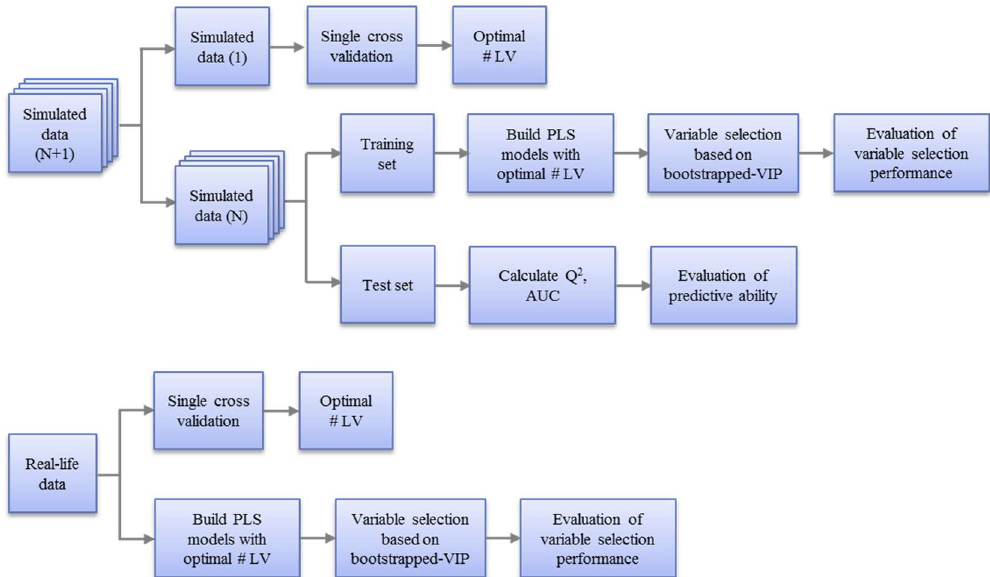
Figure 3. Workflow for the evaluation of variable selection performance of five PLS models on simulated datasets (top) and real datasets (bottom). For the simulated datasets, a single cross validation